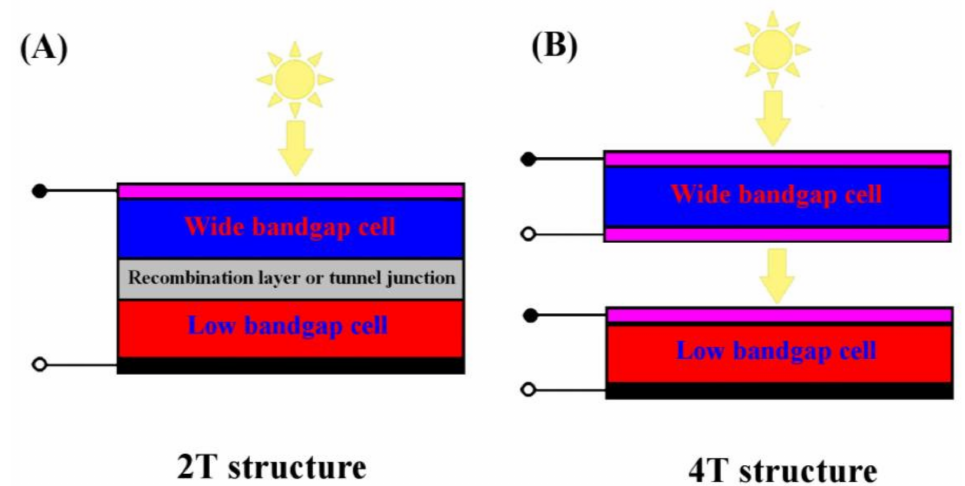
Figure 1. ( A ) 2T and ( B ) 4T topologies. The first typically consists of a monolithic structure, where the layer connecting the two cells plays the role of a recombination layer or works as a tunnel junction. The 2T structure is a mechanical stacking of two separate cells with different bandgap active